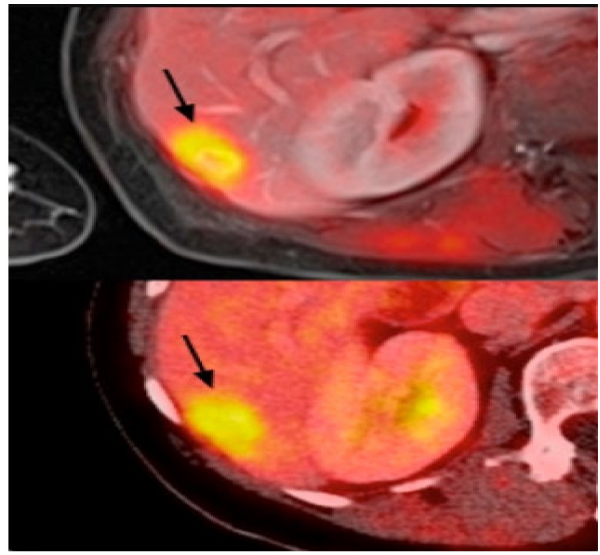
Figure 6. Example of PET images for breast cancer analysis [118]. Reprinted/adapted with permission from [118]. 2021,